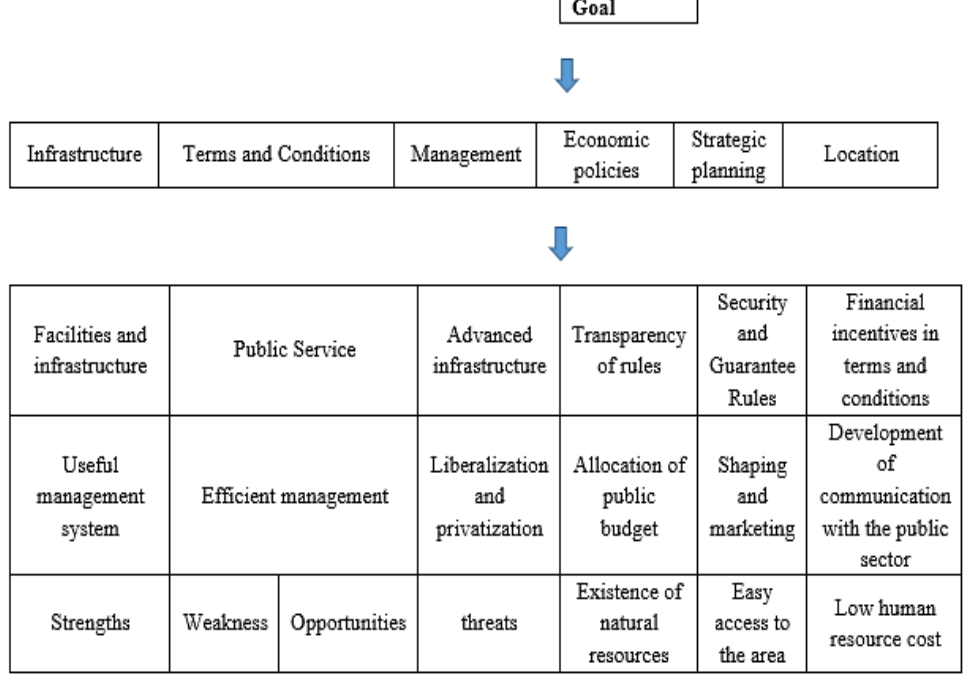
Fig. 2. The structure of the hierarchical process in the applied AHP. Table 4. Interpretation of second-level priorities.